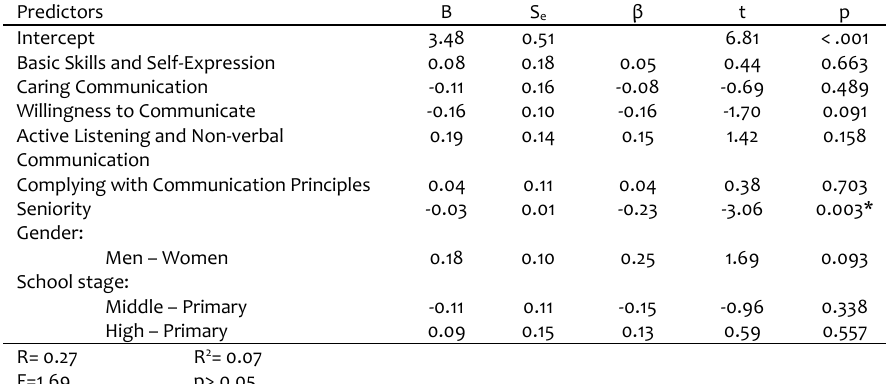
Table 5. Multiple linear regression analysis results for teachers’ level of Authoritarian